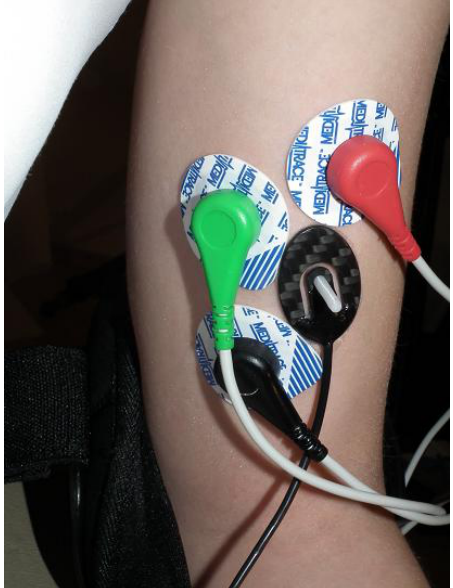
Figure 3. Position of MC sensor (black) and EMG electrodes on m. biceps